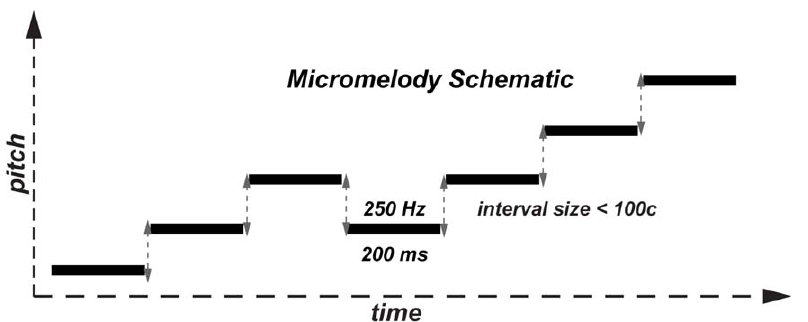
Figure 4. Schematic of the micromelodies used for auditory discrimination training and testing. Each micromelody consists of seven notes (each 200 ms in length; ISI of 150 ms between each note not illustrated), with the pitch of the middle note always at 250 Hz (the training frequency). The intervals between notes (in double-headed, dashed arrows) were always less than 100 cents (or a semitone).